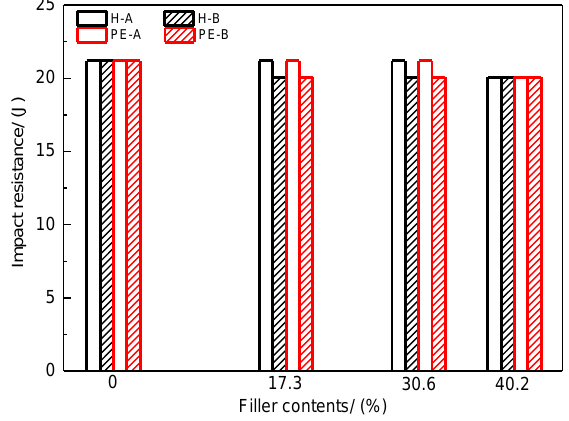
Figure 10. Impact resistances of samples.